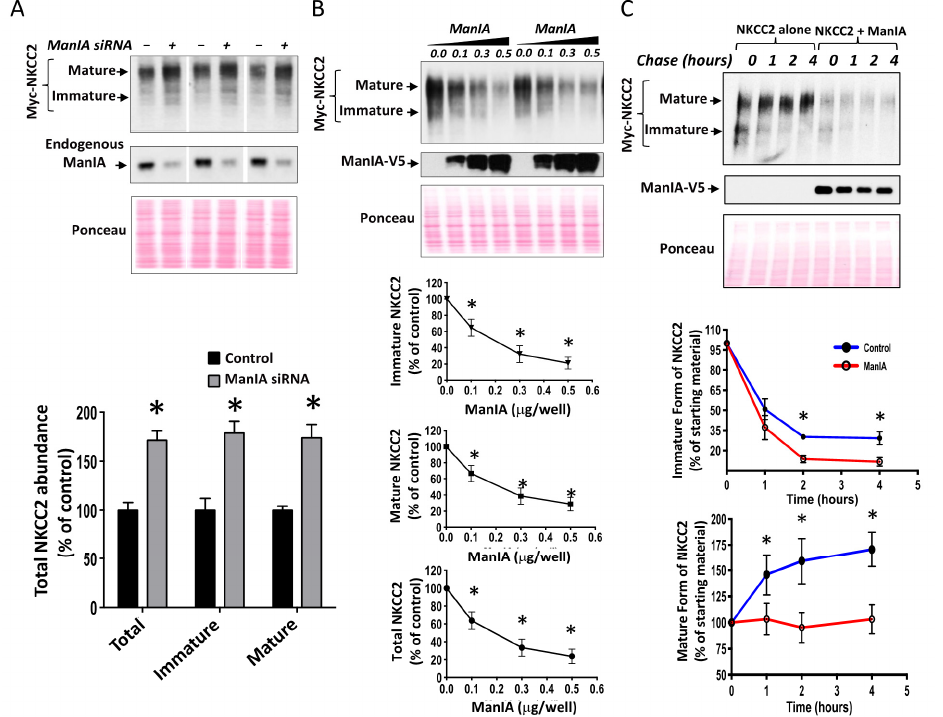
Figure 3. ManIA impedes NKCC2 stability and maturation. ( A ) Knockdown of endogenous ManIA in HEK cells increases immature and mature NKCC2 protein abundance. Upper panels , Representative immunoblot showing the effect of ManIA knockdown on NKCC2. HEK cells were transfected with NKCC2 without ( − ) or with specific ManIA siRNA (+). 48 h post-transfection, total cell extract from each sample was run on a parallel SDS gel and immunoblotted for total NKCC2 using Myc antibody. Lower panels, quantitative analysis of NKCC2 protein abundance. Data were normalized with the loading control (Ponceau staining) from the same lane in each membrane and are expressed as percentage of control. * p < 0.0004 ( n = 3) versus control. ( B ) Total NKCC2 protein abundance is reduced by ManIA in a dose-dependent fashion. HEK cells were co-transfected with Myc-NKCC2 (0.1 µ g/well) and increasing amounts of ManIA (0.1–0.5 µ g/well) as indicated. NKCC2 proteins were detected by Western blotting with Myc antibody ( left panel ). Lower panels , densitometric analysis of total, immature and mature NKCC2 proteins with or without ManIA co-expression. Data are expressed as a percentage of control ± SE, * p < 0.05 ( n = 4), versus control. ( C ), ManIA decreases NKCC2 stability and maturation. Upper panel , representative immunoblot showing cycloheximide chase analysis of NKCC2 in the presence or absence of ManIA-V5. 14–16 h post-transfection, HEK cells transiently expressing WT NKCC2 alone or in combination with ManIA, were chased for the indicated time after addition of cycloheximide. Total cell lysates were separated by SDS-PAGE and probed by anti-Myc and anti-V5 antibodies. Lower panels : Quantitative analysis of NKCC2 stability and maturation. The density of the mature and immature form of NKCC2 proteins was normalized to the density at time 0. * p < 0.05 versus control ( n =